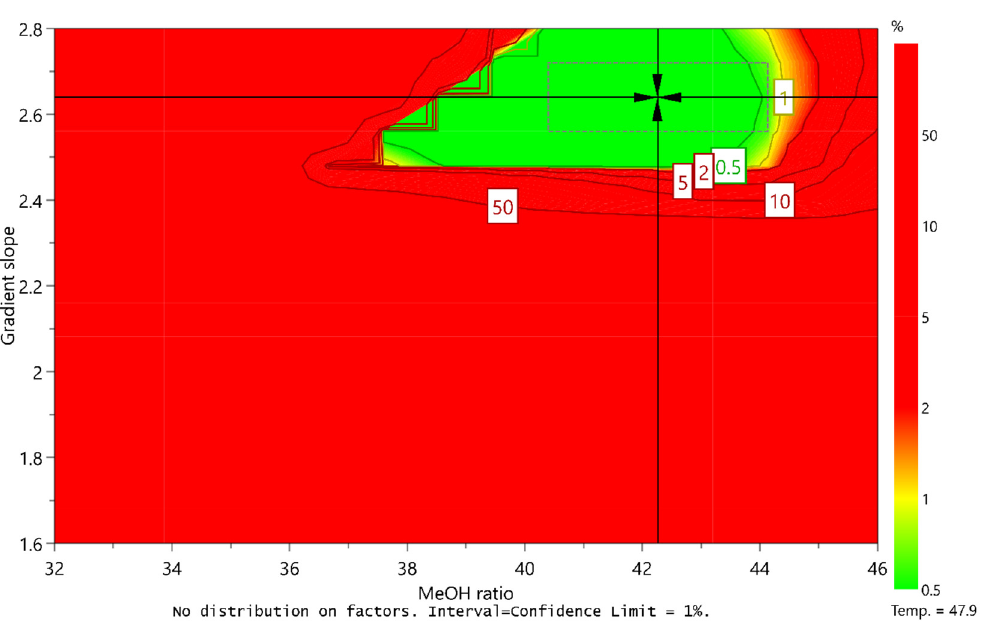
Figure 7. Design space for a central composite face-centered design MLR fitted model when unknown degradation impurity is eluting after impurity C by plotting the ratio of methanol in MP B versus gradient slope at a column temperature of 47.9 °C. Predicted optimal conditions of CMPs are marked with a cross and the defined robustness region is marked with a dashed line.